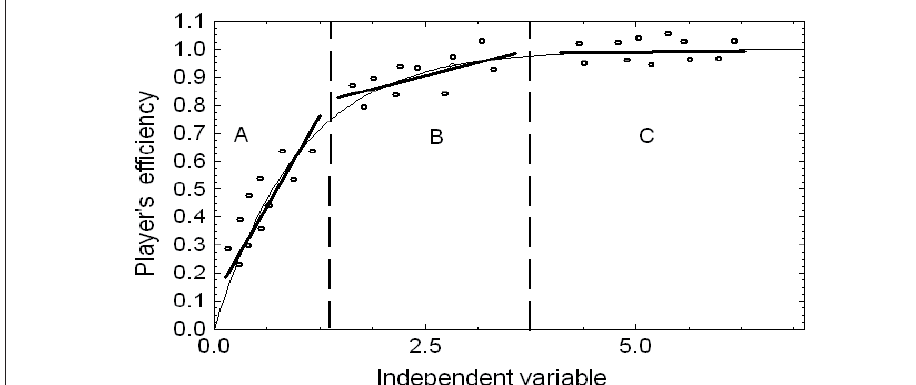
Figure 4. A schematic representation of possible types of experimental